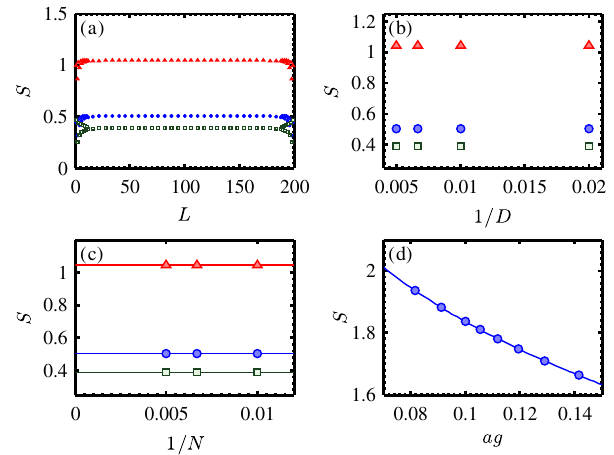
FIG. 8. (a) The different contributions to the entanglement entropy, S (blue circles), S (red triangles), and S (green dist class rep squares), for the RDM of the leftmost L sites for N ¼ 200 , 2 . (b) Entropy contributions D ¼ 200 , m=g ¼ 0 . 8 , and j max ¼ averaged over four bipartitions close to the center as a function of bond dimension. (c) Averaged entropy contributions for D ¼ 200 , 2 as a function of system size. (d) Con- m=g ¼ 0 . 8 , and j max ¼ tinuum extrapolation for the total entropy. In panels (b) – (d) the error bars of the data points are smaller than the markers.